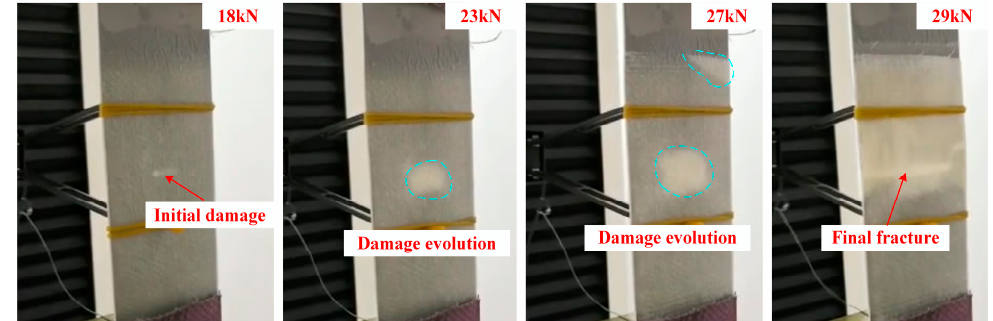
Figure 5. Visual inspected damage process during loading.